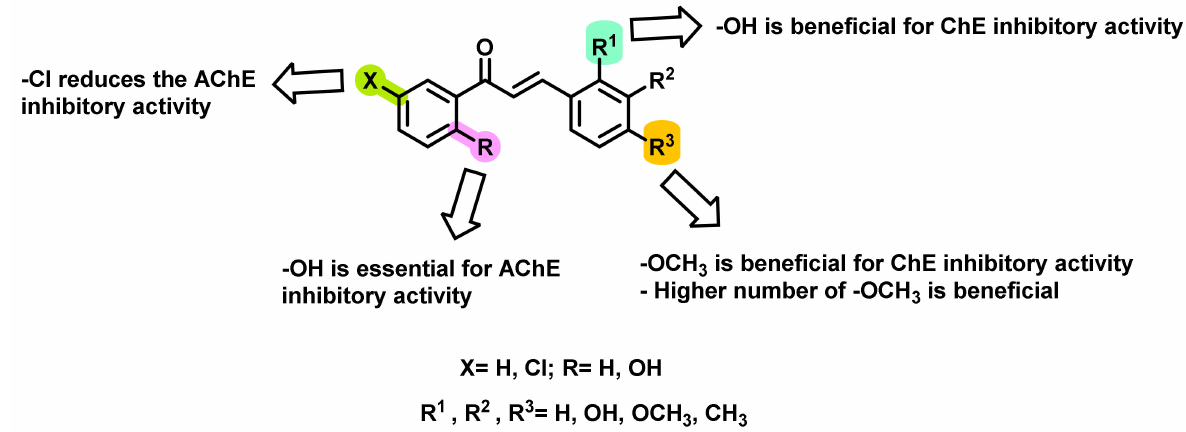
Figure 5. Chalcone derivatives with simple substitutions by Hasan et al. [39].